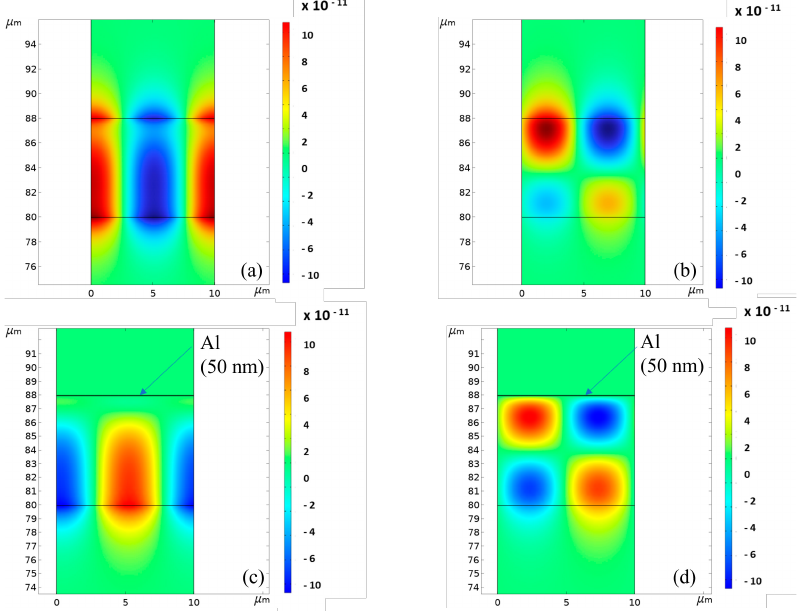
Figure 14. The electric potential of the ( a ) Rayleigh and ( b ) Sezawa modes in ZnO (8 µ m)/SiO 2 ; ( c ) that of the Rayleigh and ( d ) Sezawa waves in Al (50 nm)/ ZnO (8 µm)/SiO 2 . Figures 15 and 16 show, as an example, the electric potential distribution under the Rayleigh mode at some conductivity values (the running parameter), under top and bottom illumination and assuming δ UV = 200 nm.